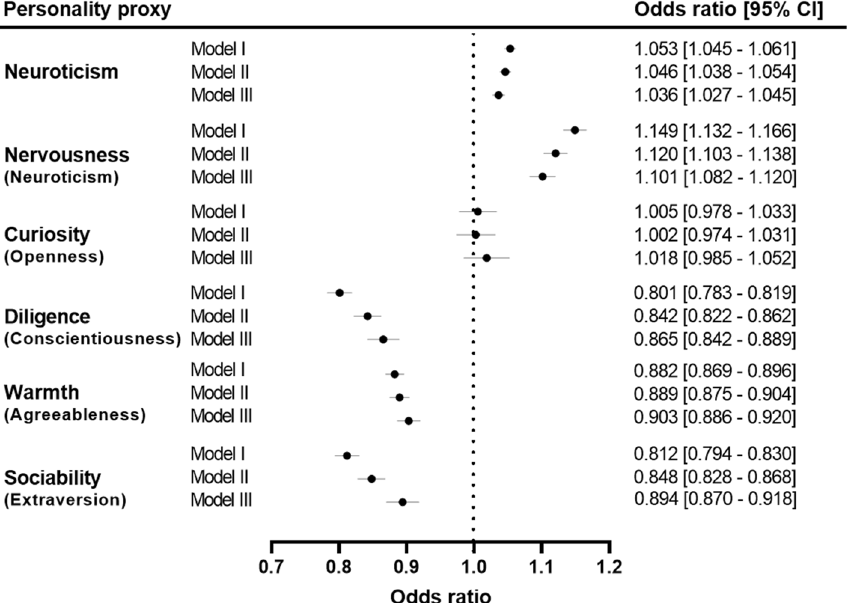
Figure 2. Association of neuroticism and personality trait proxies with prevalent myocardial infarction. Labels in small brackets represent original Big Five personality trait corresponding to each personality trait proxy. Model I: analyses were adjusted for demographic factors (sex, age, Townsend Deprivation Index and ethnic background). Model II: analyses were adjusted for health-related measures (body mass index, systolic blood pressure, diastolic blood pressure and diabetes) in addition to demographic factors. Model III (or fully adjusted model): analyses were adjusted for lifestyle factors (alcohol intake frequency, smoking status, and physical activity) in addition to demographic factors and health-related measures. The plot was created using GraphPad Prism